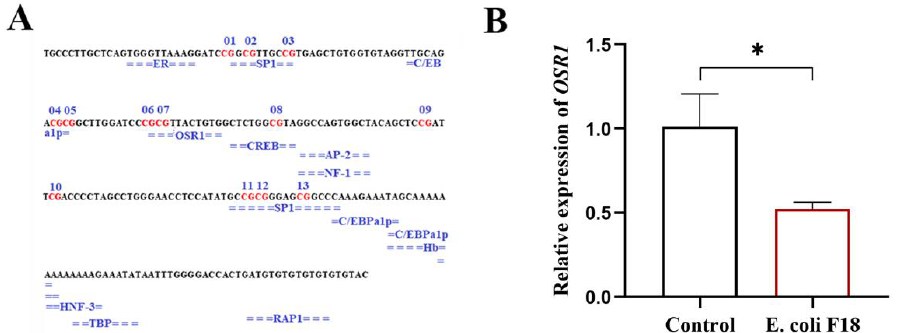
Figure 6. Putative TFBSs prediction results for the CpG island of the CXCL11 promoter sequence and the relationship of the key TF with E. coli F18 resistance. ( A ) Putative TFBSs prediction results for the CpG island of the CXCL11 promoter sequence. Red font indicates the methylated CpG sites, Blue font below red font means the predicted TFs. ( B ) Differential expression investigation of the key TF gene between E. coli F18-infected and -uninfected IPEC-J2, * p < 0.05.